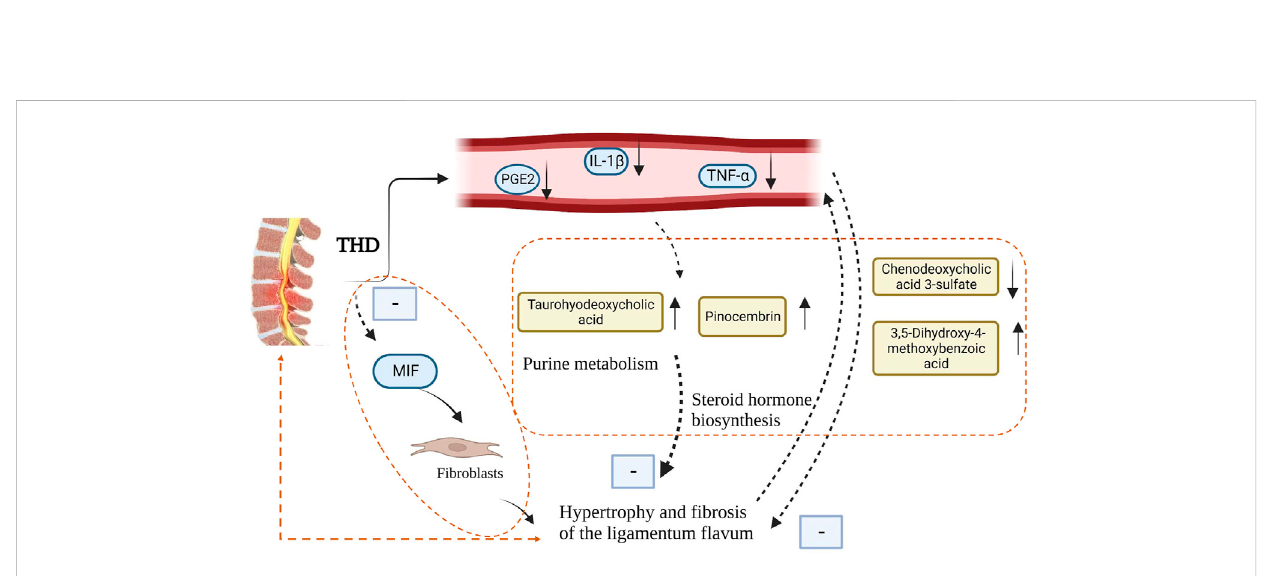
FIGURE 10 THD intervenes in LSS metabolic pathway mechanism